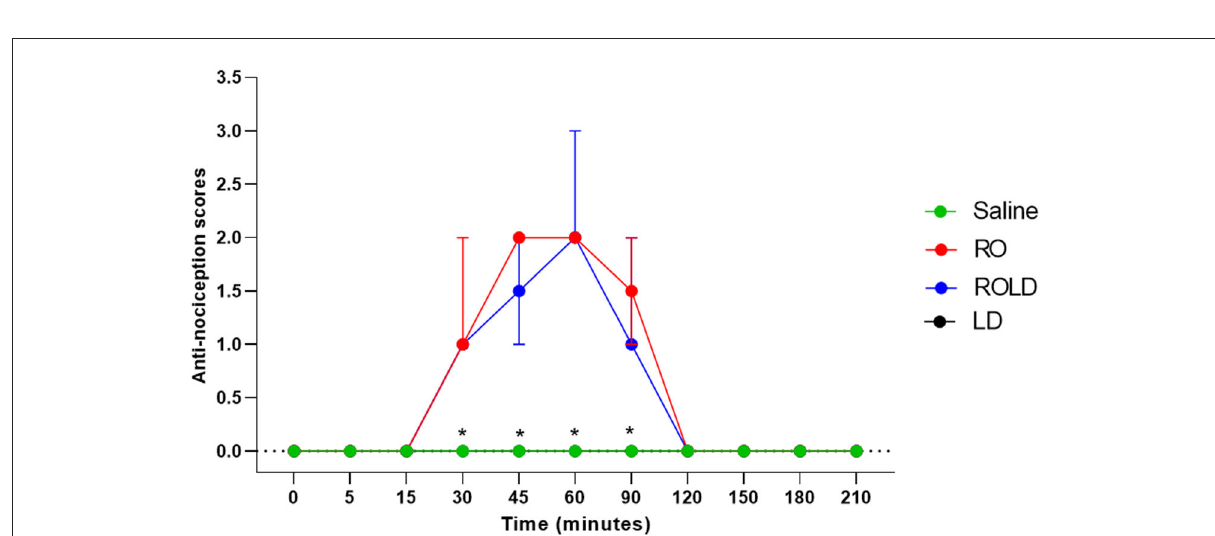
FIGURE2 Anti-nociception scores (median and range) in the dorsal metatarsal and ventral abdominal wall regions (Response to “pin-prick” stimulation) pre- epidural and post- epidural administration of saline ( n = 6), romifidine (RO) (50 µ g kg − 1) ( n = 6), romifidine-lidocaine (ROLD) (50 µ g and 0.30mg kg − 1) ( n = 6) and lidocaine (LD) (0.3 0mg kg − 1) ( n = 6) in donkeys. *: Saline and LD differ significantly from RO and ROLD